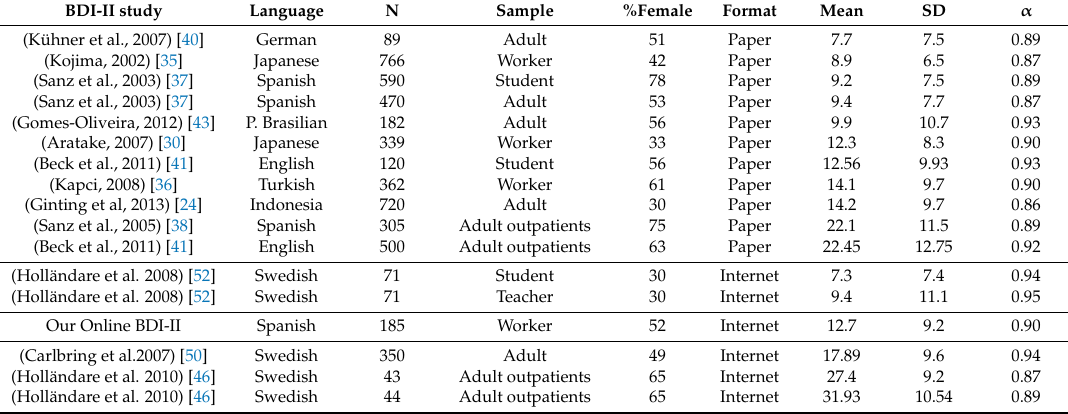
Table 7. BDI-II studies by language version, sample size, target sample, gender distribution, format (paper/Internet), total score mean (standard deviation) and reliability ( α ) order by format and mean value.